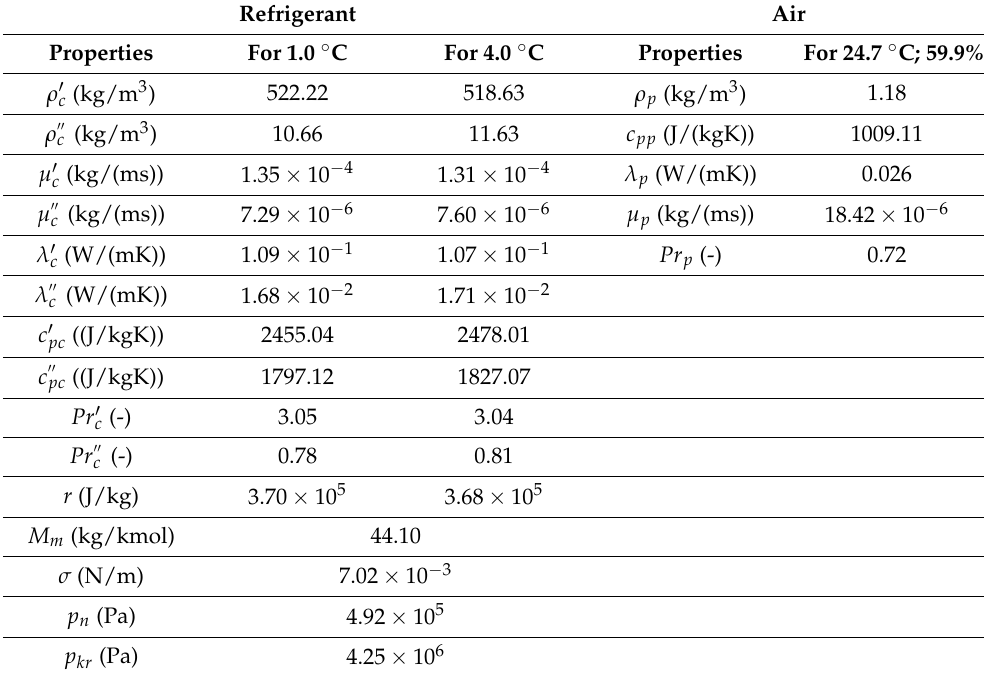
Table 2. Thermodynamic properties for air and refrigerant.